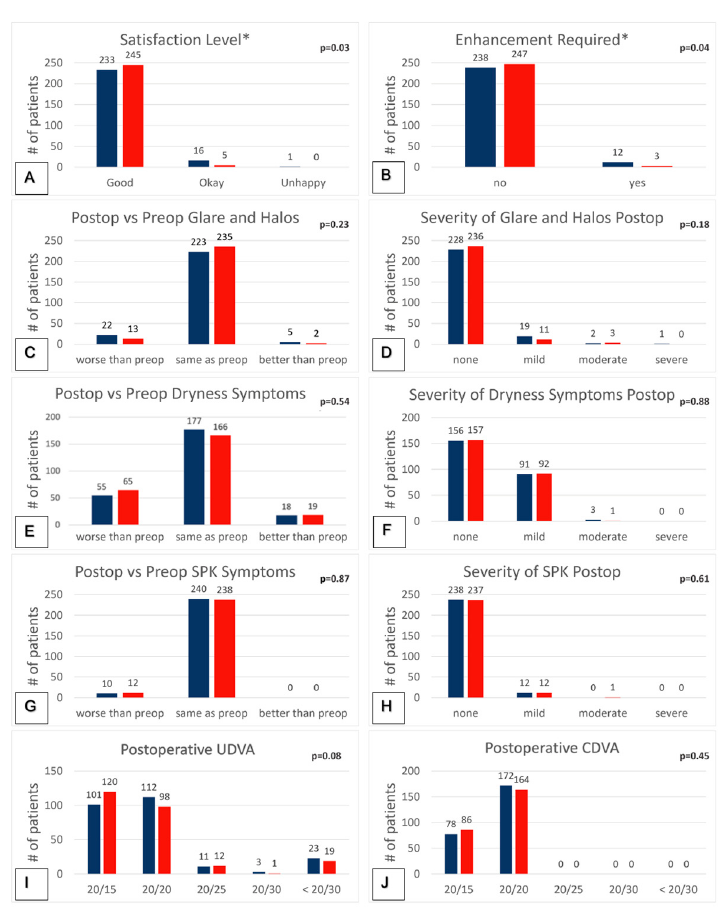
Figure 5. Comparison of patient − reported subjective symptoms between 6.0 and 6.5 mm groups. ( A ) Satisfaction level categorized as “good”, “okay”, and “unhappy”; ( B ) enhancements pursued postoperatively; ( C ) comparison of preoperative and postoperative glare and halos; ( D ) severity of postoperative glare and halos; ( E ) comparison of preoperative and postoperative dry eye symptoms; ( F ) severity of postoperative dry eye symptoms; ( G ) comparison of preoperative and postoperative superficial punctate keratitis (SPK); ( H ) severity of postoperative SPK; ( I ) postoperative UCVA characterized by Snellen; ( J ) postoperative CDVA characterized by Snellen. * statistically significant p < 0.05 using a Pearson’s Chi-square or Fisher’s exact test with post-hoc Hochberg